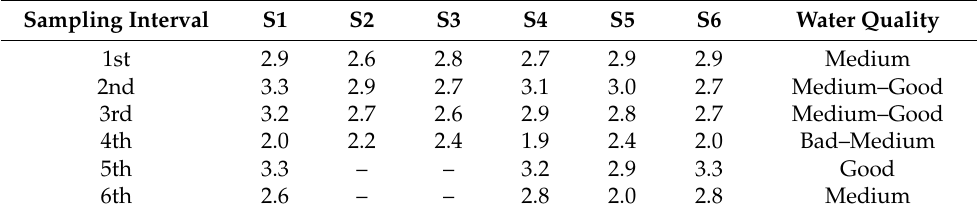
Table 2. The diversity index H (cid:48) in the study area over sampling sites and intervals. Sampling